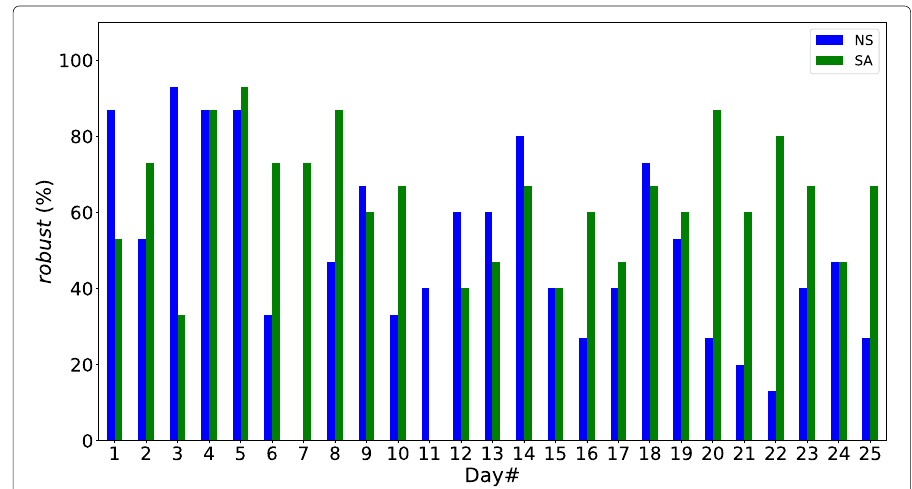
Fig. 13 Winters. For error percentage as high as 20%, note that SA has less deviation in HVAC operations than